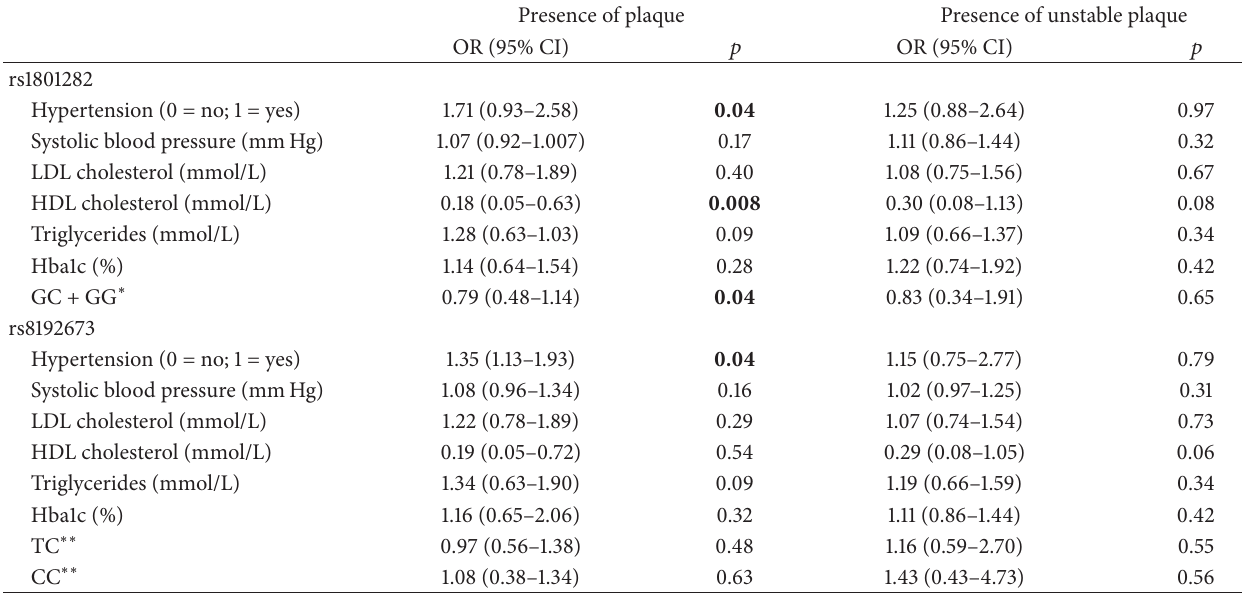
Table 5: Association of the rs1801282 genotypes with the presence of plaques and presence of unstable plaques in patients with T2DM at the time of recruitment.